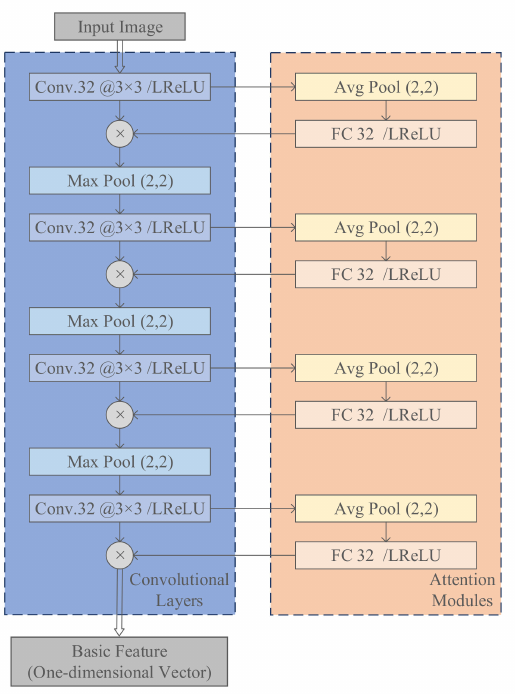
Figure 2. The network structure of the feature